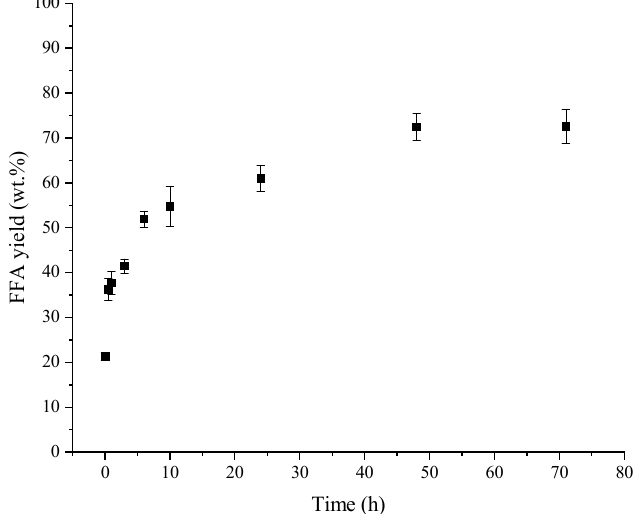
Figure 1. Free fatty acid (FFA) yield profile (wt.%) vs. time for the hydrolysis of SODD by the en- Eversa Transform 2.0. Reaction conditions: up to 72 h reaction; 37 ◦ C; 4:1 mass ratio (H 2 O:SODD) zyme Eversa Transform 2.0. Reaction conditions: up to 72 h reaction; 37 °C; 4:1 mass ratio (H 2 O:SODD) and 5% enzyme (m/mSODD). and 5% enzyme